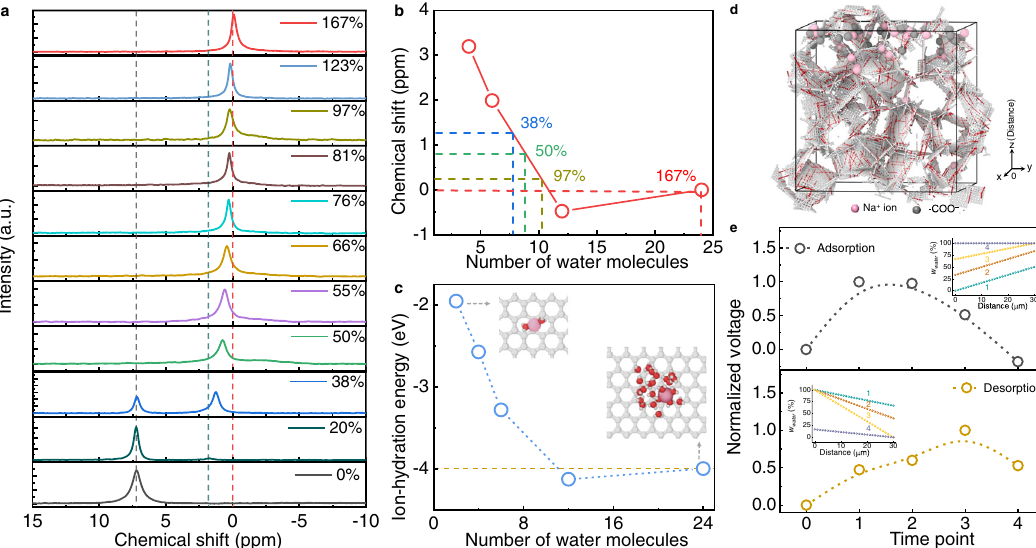
Fig. 5 Veri fi cation of working mechanism by NMR experiments and theoretical calculations. a 23 Na solid NMR spectra of SAG fi lm with different water content during desorption process. b Chemical shifts variation with number of water molecules according to fi rst principle calculation. c Simulated ion- hydration energy of hydrated Na + ion with different numbers of water molecules by MD simulations. Insets are the calculated con fi gurations of hydrated Na + ion with 2 or 24 water molecules. Hydration enthalpy of Na + ions is about − 4 eV in aqueous solution. d Model of kinetic Monte Carlo simulation. The positively charged ions of Na + and negatively charged groups anchored on the backbone could be ionized by interaction with water molecules in theoretical model. e The calculated normalized voltage under varied water content distribution during adsorption and desorption process. Time point represents a moment of adsorption or desorption process. Insets are water content distribution along with distance under different time point. W water denotes as water